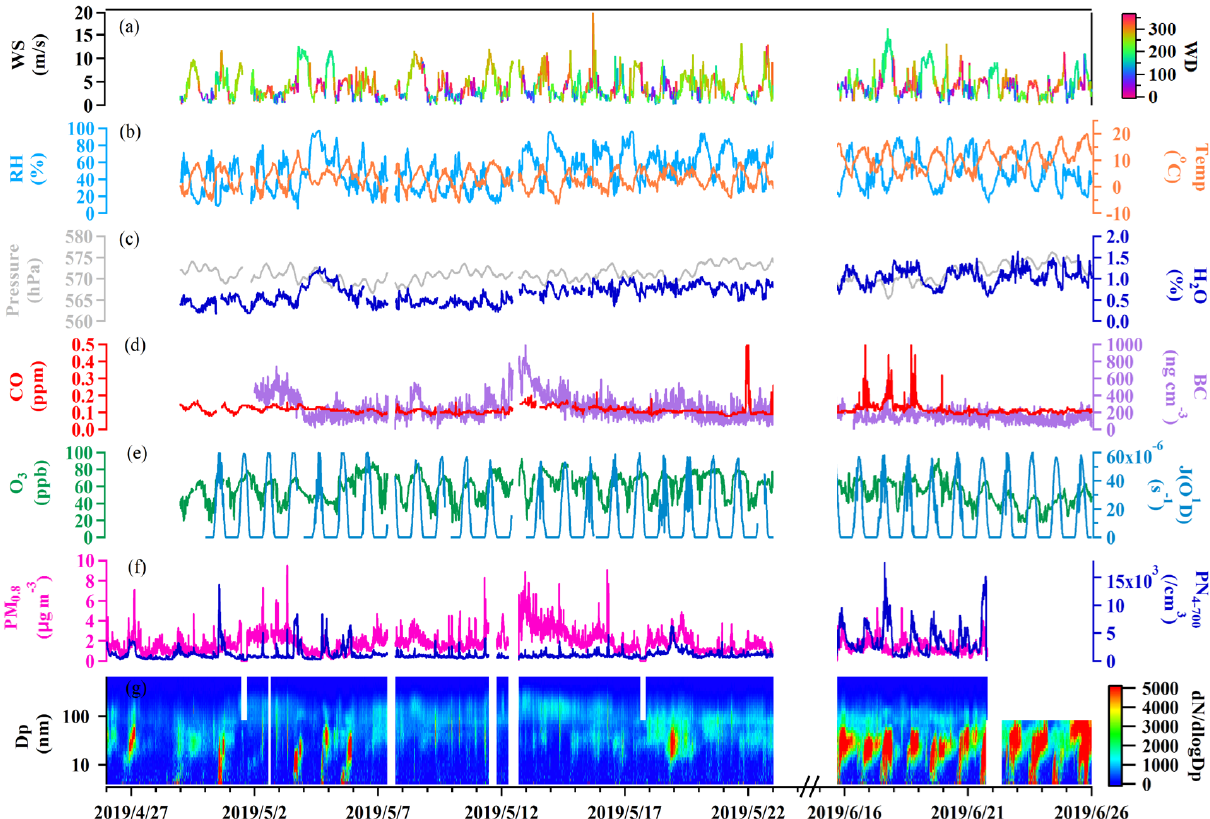
Figure 2. Time series during pre-monsoon and monsoon: (a) the wind speed and wind direction, (b) the ambient temperature and the relative humidity (RH), (c) the pressure and water content (H 2 O) in air, (d) CO concentration and the black carbon (BC) concentration, (e) O 3 concentration and the photolysis frequencies of O 3 (JO 1 D), (f) the PM 0 . 8 mass concentration and the number concentration of particles in size of 4–700nm (PN 4 − 700 ), (g) the particle number size distributions